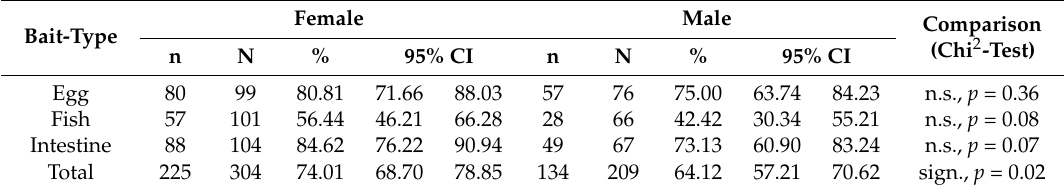
Table 5. Bait acceptance and body size (small, medium) of the dogs. Only a few large-sized dogs were included in the study and therefore they were not included in the analysis (n = number of baits